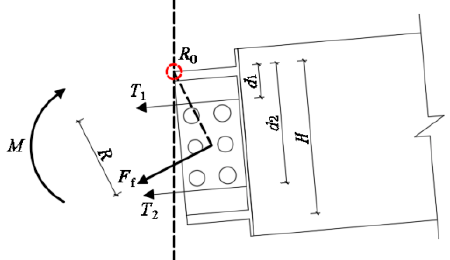
Figure 2. Calculation diagram of the bending moment (joint opened).